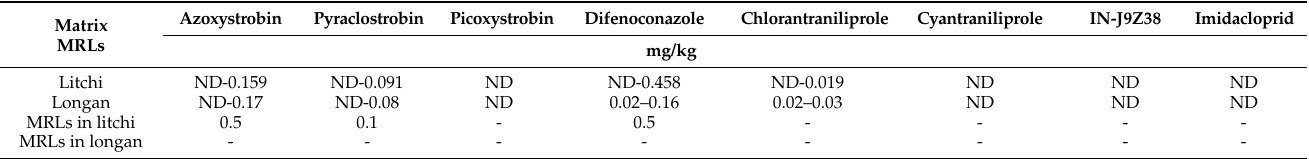
Table 5. Residues of eight targeted compounds in real litchi and longan